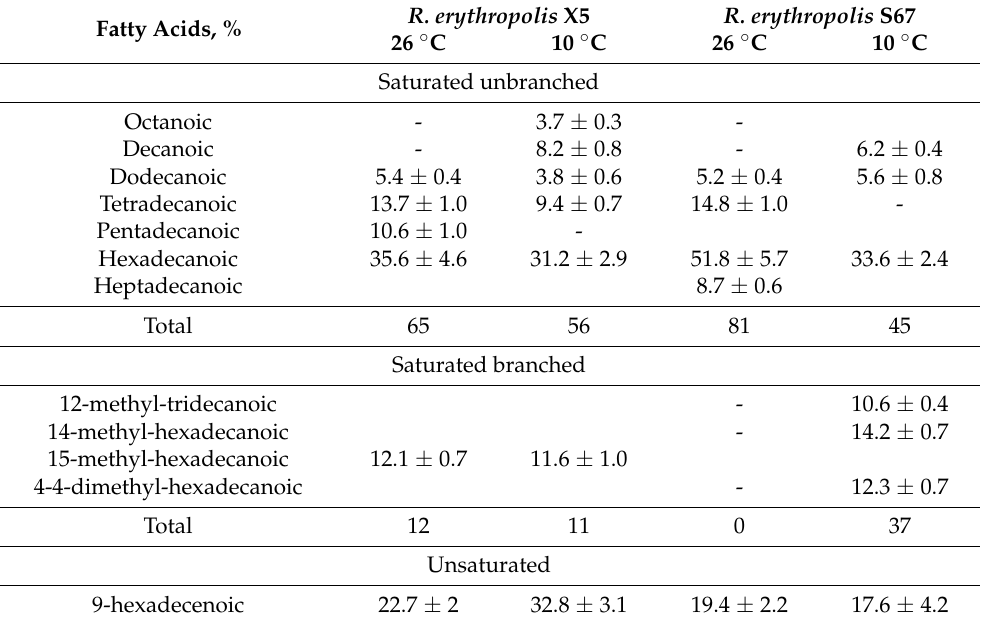
Table 2. Fatty acid composition of cell lipids of strains X5 and S67 when grown on hexadecane in different aggregate states. Fatty Acids,